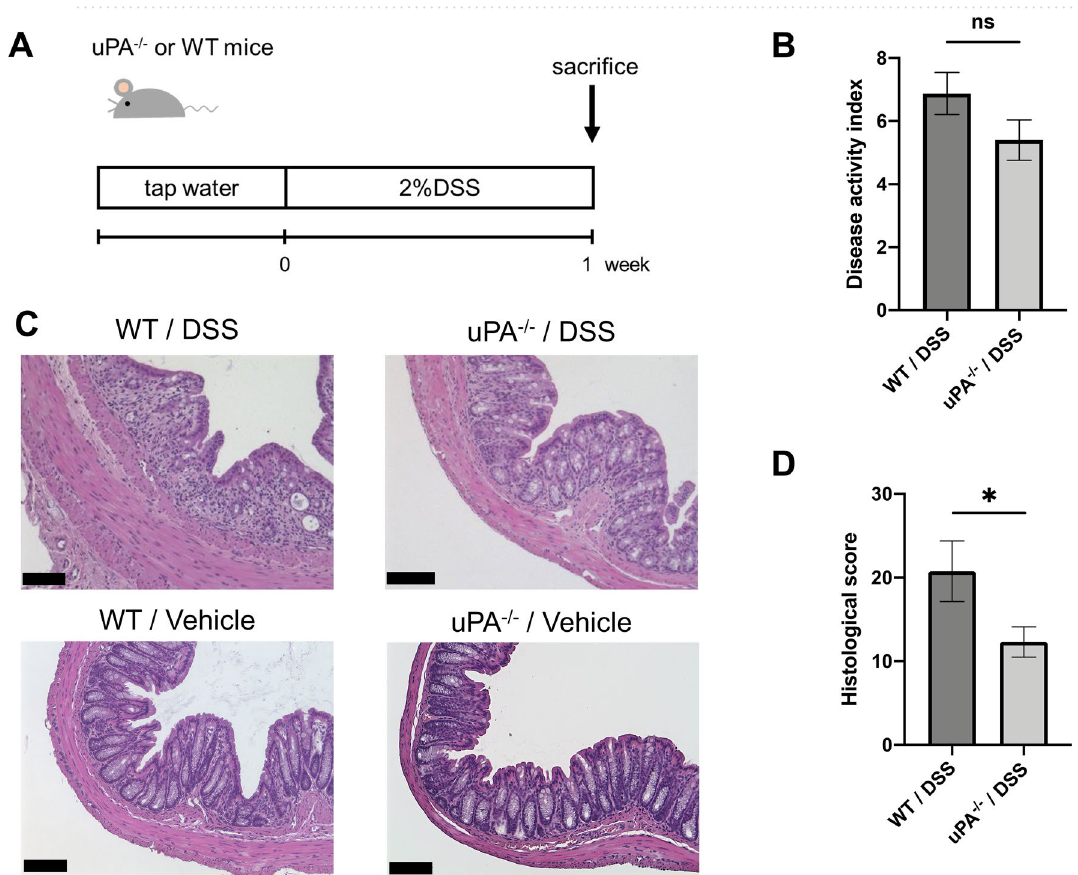
Figure 3. Effect of uPA knockout on DSS-induced colitis. ( A ) Male uPA −/− mice (n = 10) and WT mice (n = 8) were administered 2% DSS in their drinking water for 1 week and sacrificed at day 8. ( B ) DAI was evaluated at day 8 by the scoring method of Cooper et al. 10 ( C ) Representative H&E staining of colon sections from WT and uPA -/- mice treated with DSS and control mice. Scale bar, 100 μm. ( D ) Histologic score of H&E staining image was evaluated by the scoring method of Williams et al. 11 Data represent mean ± SEM. * p < 0.05 by Student’s t